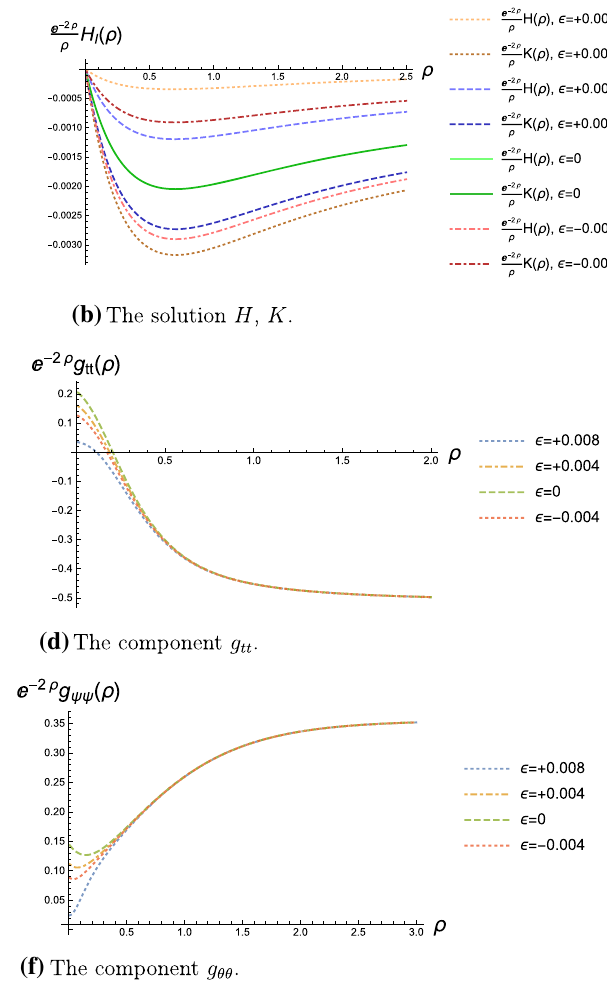
size that both g θθ and g ψψ are positive in all the ρ ≥ 0 region, so our solution does not have any CTCs. Since instead g tt assumes positive values near the horizon, our solution does have an